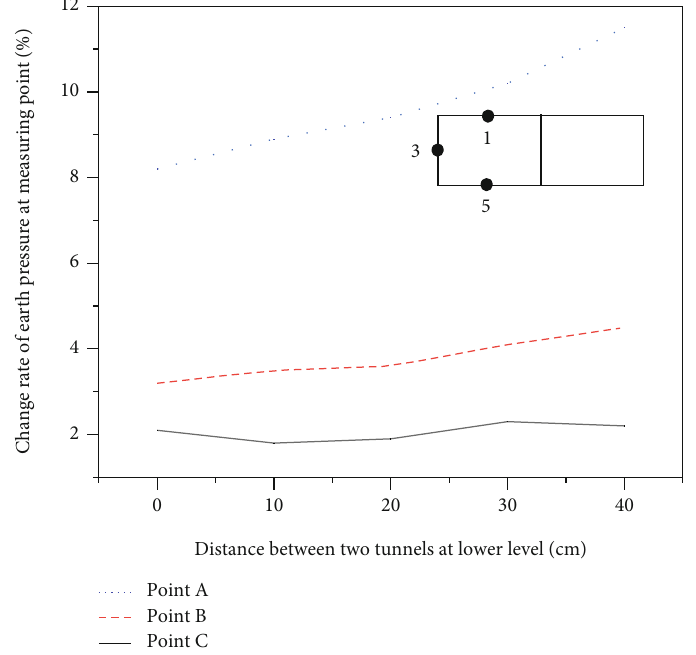
Figure 14: Change rate of axial force of upper fl oor under di ff erent spacings.